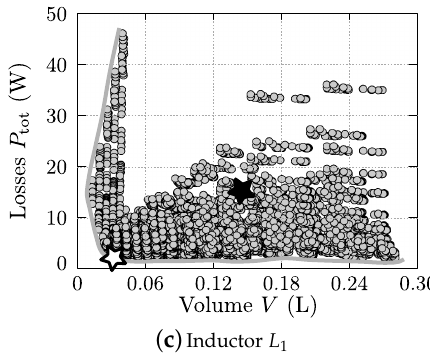
Figure 14. Two-dimensional losses vs. volume performance spaces for ( a ) the high-frequency (HF) ac-link transformer; ( b ) inductor L ext ; ( c ) inductor L 1 , calculated for nominal DAB operating